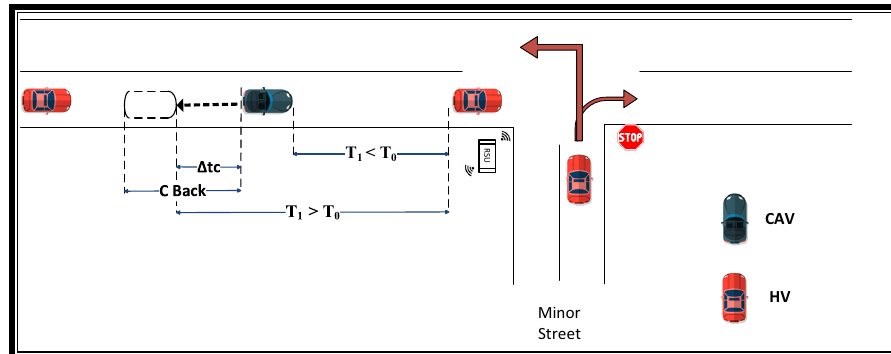
Figure 6: The back gap and front gap after speed reduction.